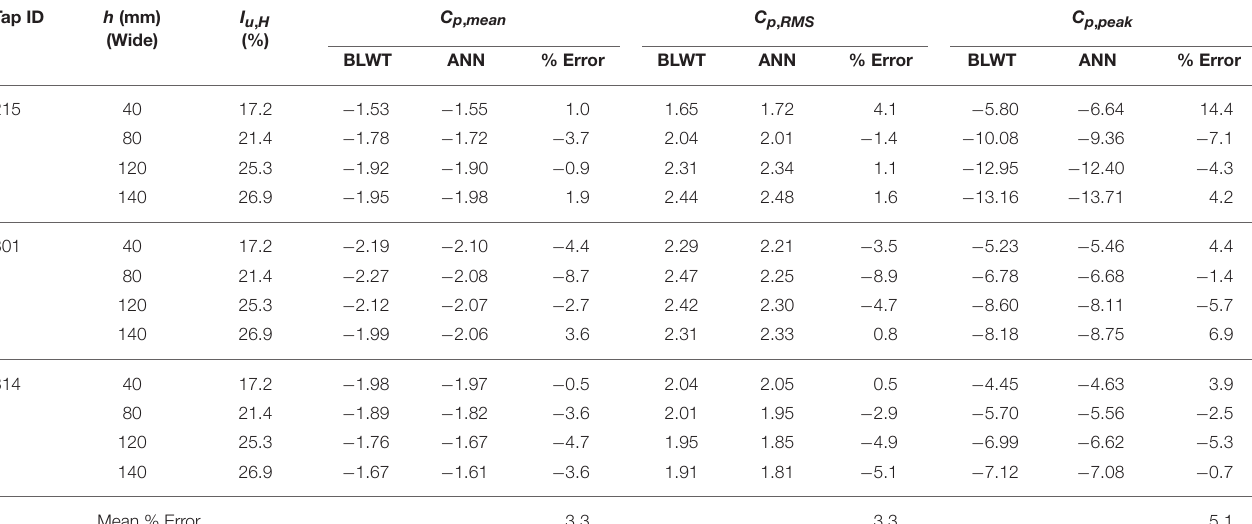
TABLE 4 | Prediction of mean, RMS, and peak pressures for taps 215, 301, and 314 on the 1:50 building model. Tap ID h (mm)